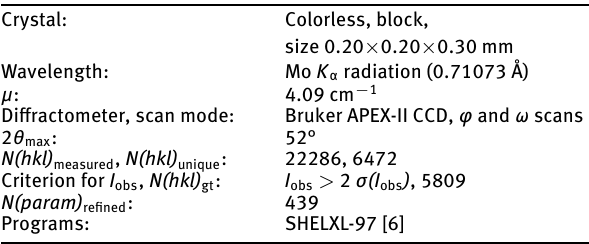
Table 2: Fractional atomic coordinates and isotropic or